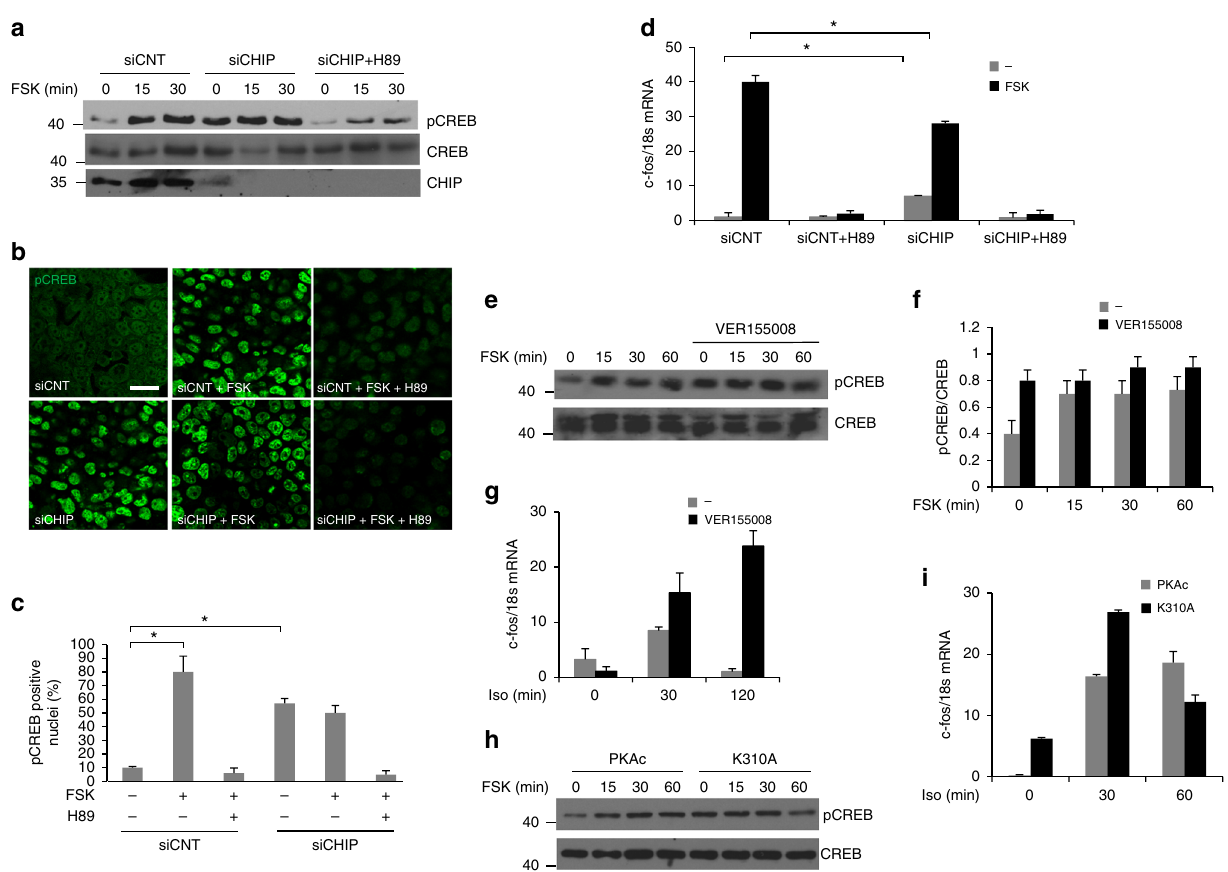
Fig. 6 CHIP controls nuclear cAMP signaling. a Cells were transfected with siRNAs (control or siRNA targeting CHIP), serum deprived overnight and then stimulated with FSK. Where indicated, cells were pretreated for 1 h with the PKA inhibitor H89 (10 μ m). Lysates were immunoblotted for phosphoSer133- CREB (pCREB), CREB and CHIP. b Same as in a , with the exception that cells were formalin- fi xed and immunostained for pCREB antibodies. Representative confocal images are shown. Scale bar, 10 μ m. c Quantitative analysis of the experiments shown in b . A mean value ± S.E.M. of three independent experiments is reported. A total of 100 cells were scored in each set of experiments. Student ’ s t test, * p < 0.05. d Quantitative PCR with reverse transcription showing c -fos accumulation in cells transfected with siRNAs (control or siRNA for CHIP). Before harvesting, cells were treated with FSK (40 μ M/90 min). Where indicated, cells were pretreated with H89 (10 μ M). The data represent a mean value ± S.E.M from three independent experiments made in duplicate. Student ’ s t test, * p < 0.05. e , f Cells were stimulated with FSK, either in absence or presence or VER155008. Lysates were immunoblotted with anti-pCREB and anti-CREB antibodies. A quantitative analysis of three independent experiments is reported as a mean value ± S.E.M. g c -fos accumulation in cells stimulated with isoproterenol (Iso) either in absence or presence or VER155008. The data represent a mean value ± S.E.M from three independent experiments made in duplicate. h Cells were transiently transfected with PKAc vectors (wild type and K310A), serum deprived overnight and then stimulated with FSK (40 μ M). Lysates were immunoblotted for pCREB and CREB. i c -fos accumulation in cells transfected with PKAc vectors (wild type or K310A) and left untreated or stimulated with isoproterenol (Iso 10 μ M). The data represent a mean value ± S.E.M from